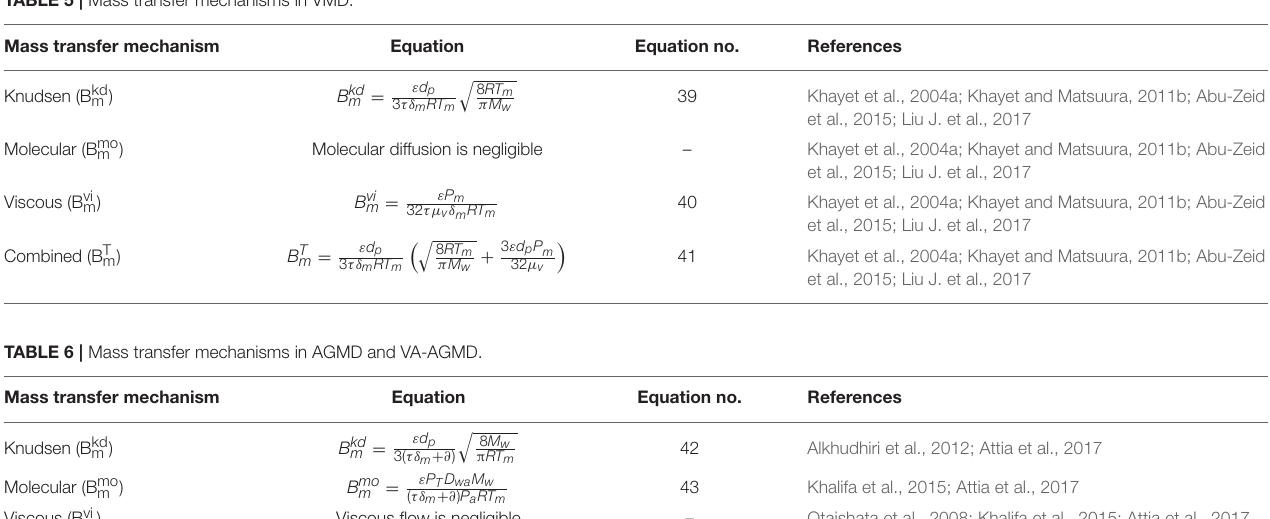
TABLE 5 | Mass transfer mechanisms in VMD.